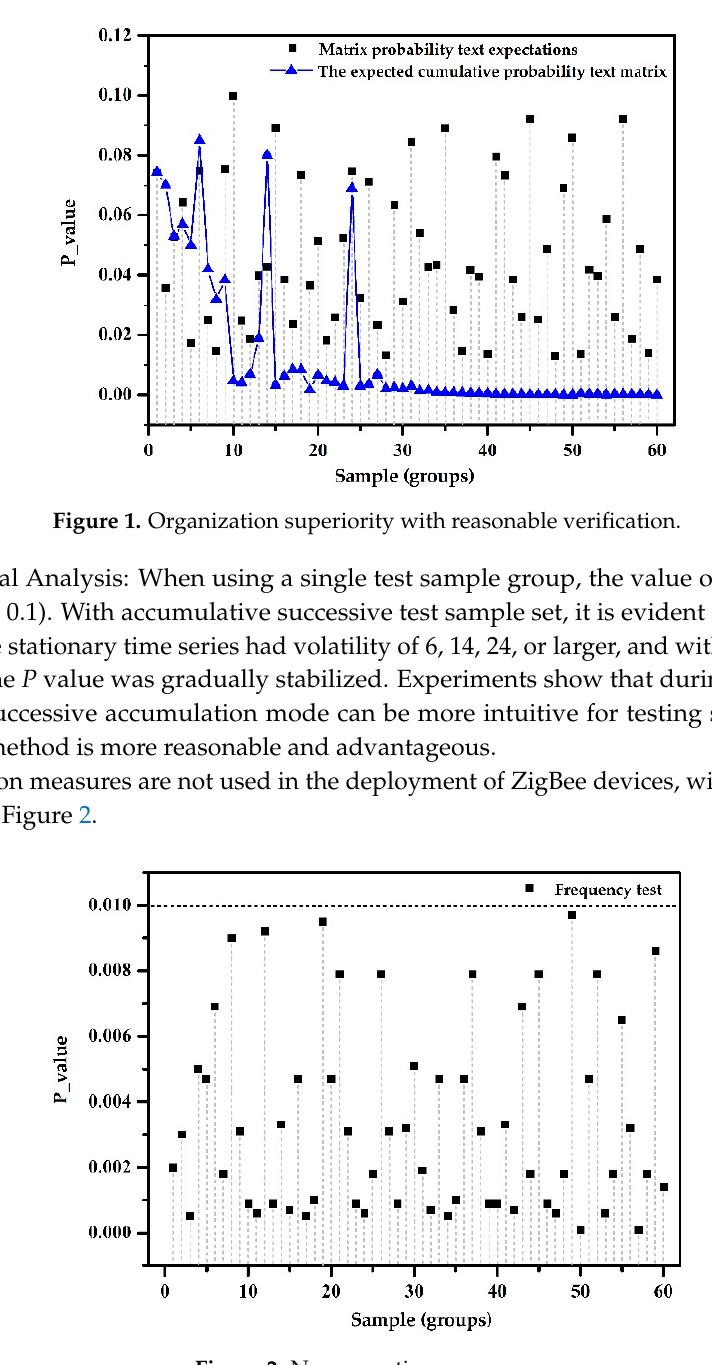
Figure 2. No encryption measures.